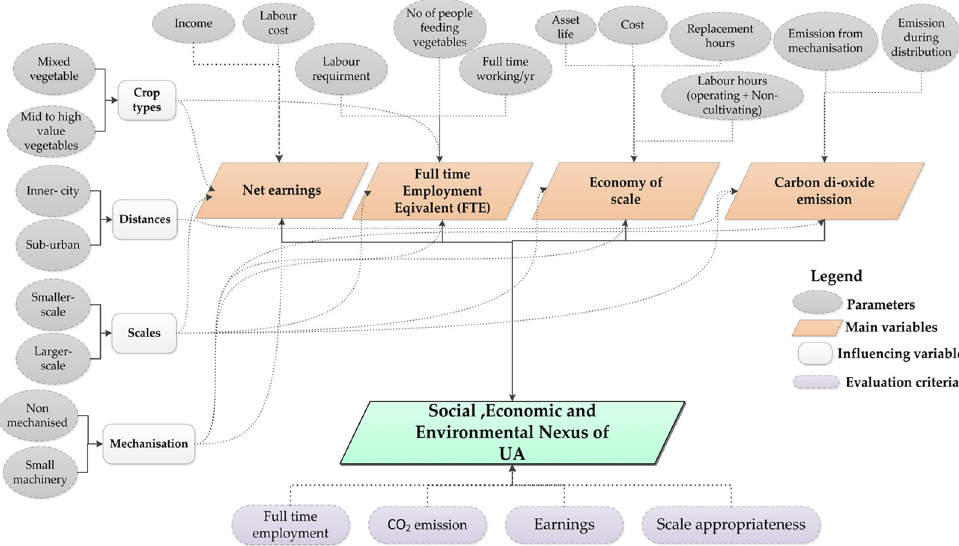
Figure 3. The conceptual framework for evaluating UA’s economic, social and environmental feasibility in this study.